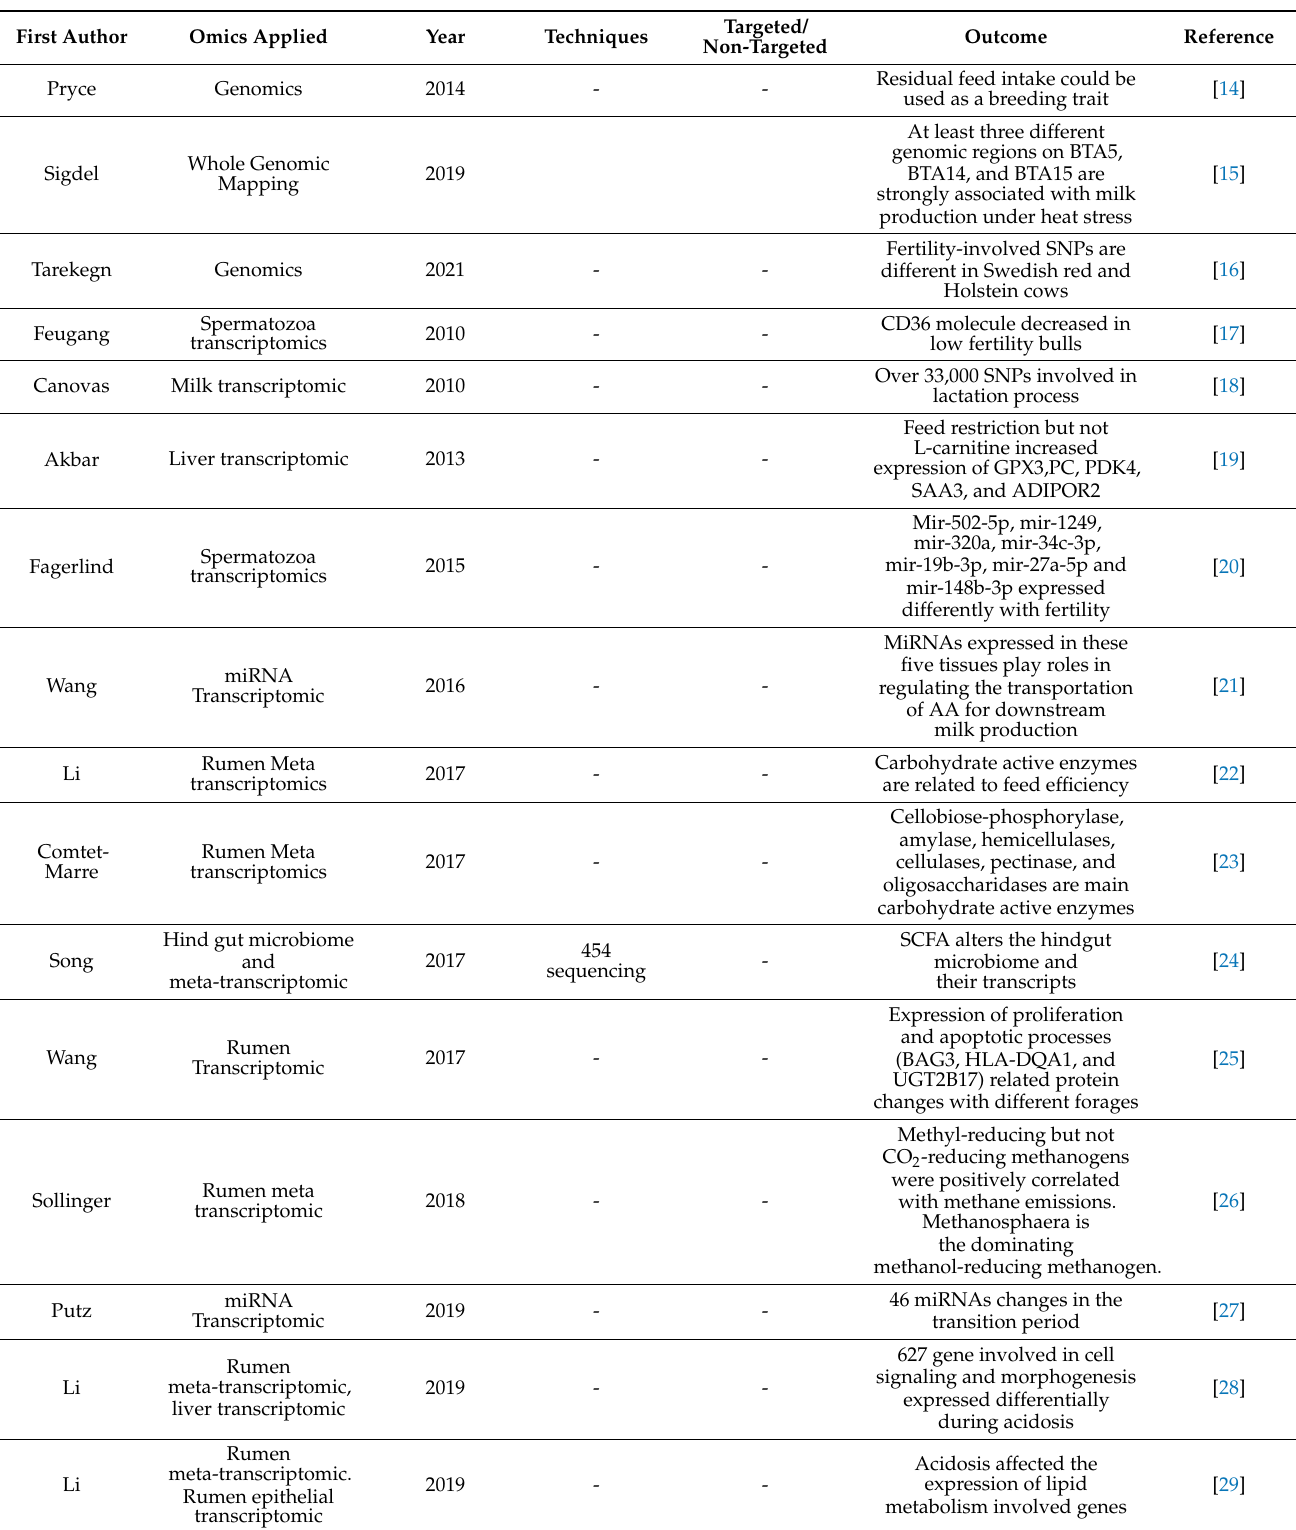
Table 1. Omics applied in the dairy